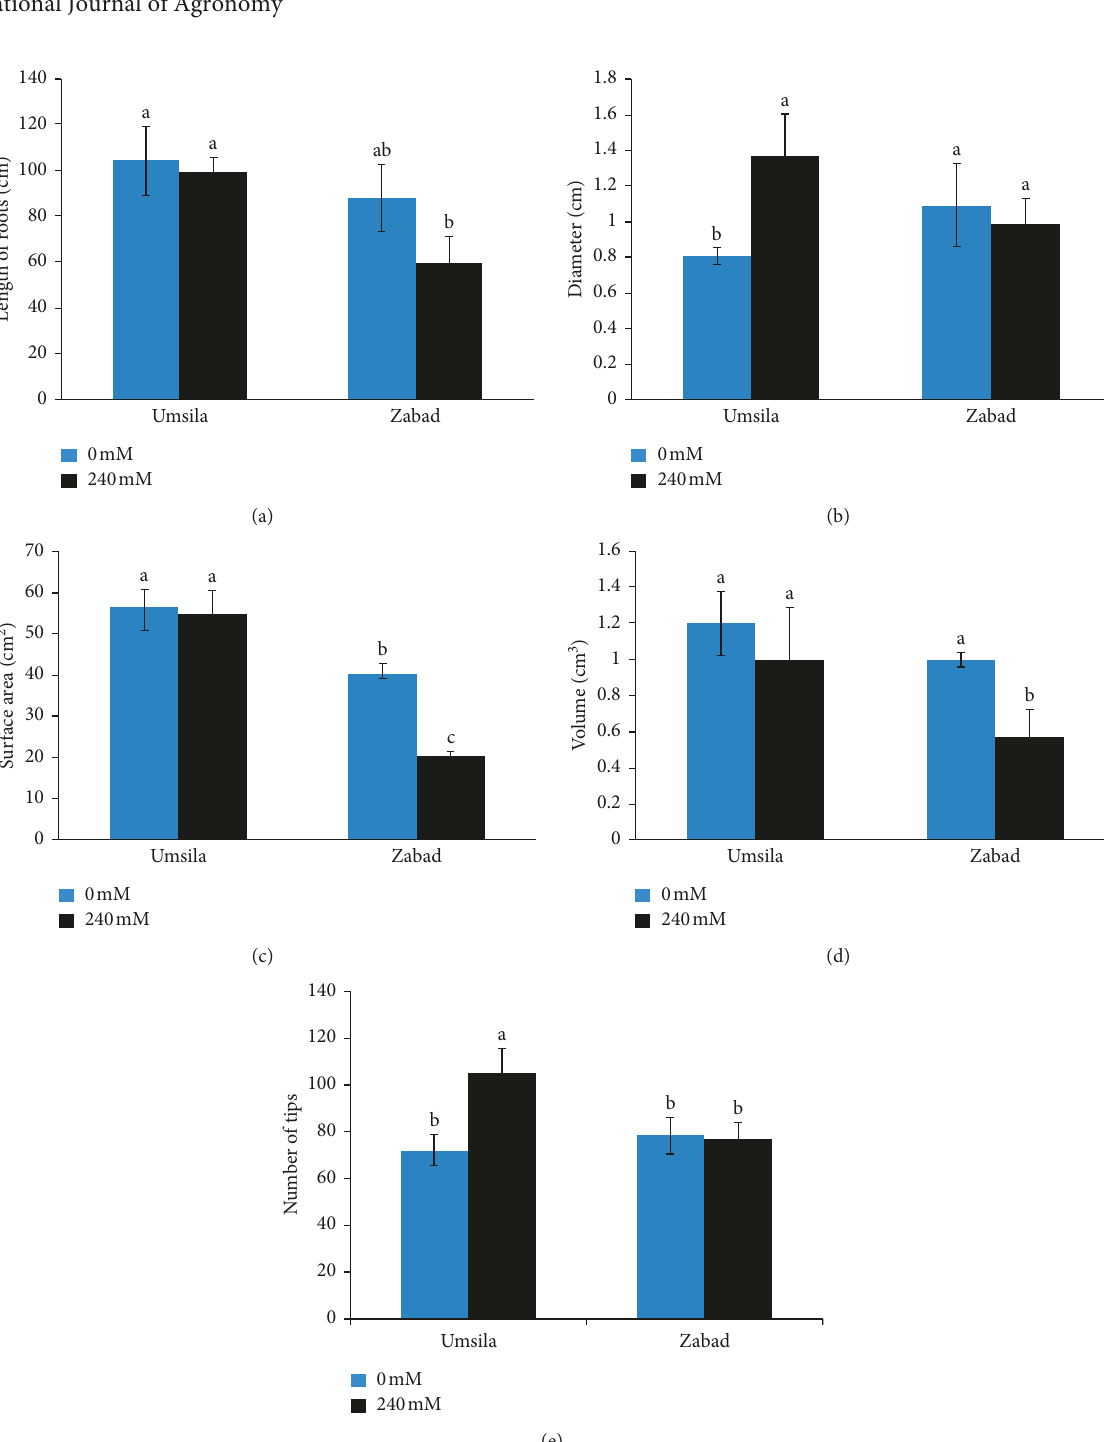
Figure 2: Measurements obtained for the root system including the length (a), diameter (b), total surface area (c), volume (d), and number of tips (e) of Umsila and Zabad seedlings grown under control and saline conditions. Bars represent mean ± SE ( n � 3). Statistical differences between the treatments were calculated based on ( p ≤ 0 .